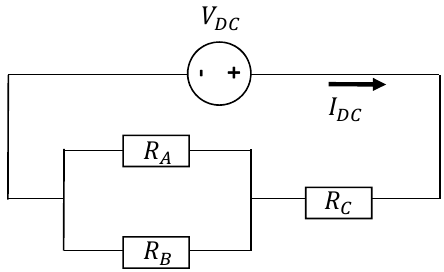
Figure 31. Circuit for measuring torque with a DC power source.